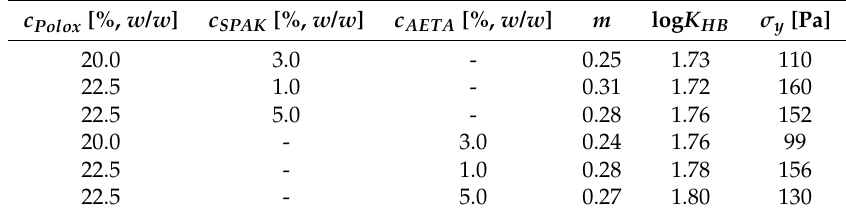
Table 2. Composition, flow index ( m ), consistency index ( K HB ) and yield stress ( σ y ) of the hydrogel formulations containing SPAK or AETA with c Polox ≥ 20% obtained from the shear stress curves using Equation (3) (see Section